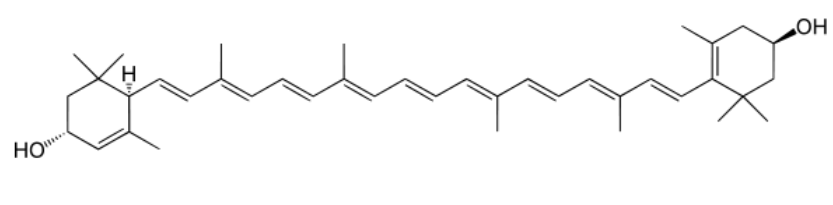
Figure 5 . Chemical structure of